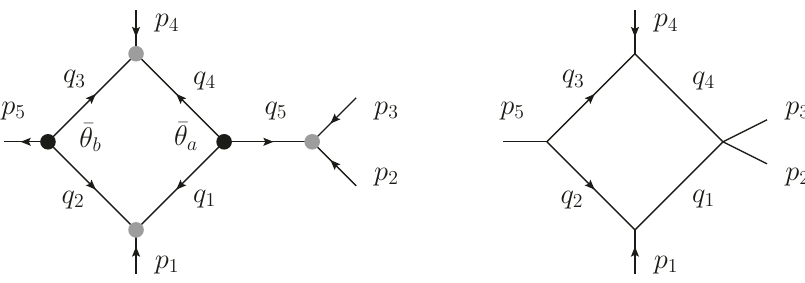
(cid:22)(cid:8)(1)(cid:22)(cid:8)(2)(cid:22)(cid:8)(3)(cid:22)(cid:8)(4)(cid:9)(5) Figure 6 . Left: one-loop NMHV 5 on-shell supegraph . Right: the corre- h i sponding bosonic integral , eq. (4.15), is a one-mass box with magic numerator. I According to (3.13), the generator S (B.4) goes through the delta functions and hits the reduced amplitude (cid:22) , which has no Grassmann I